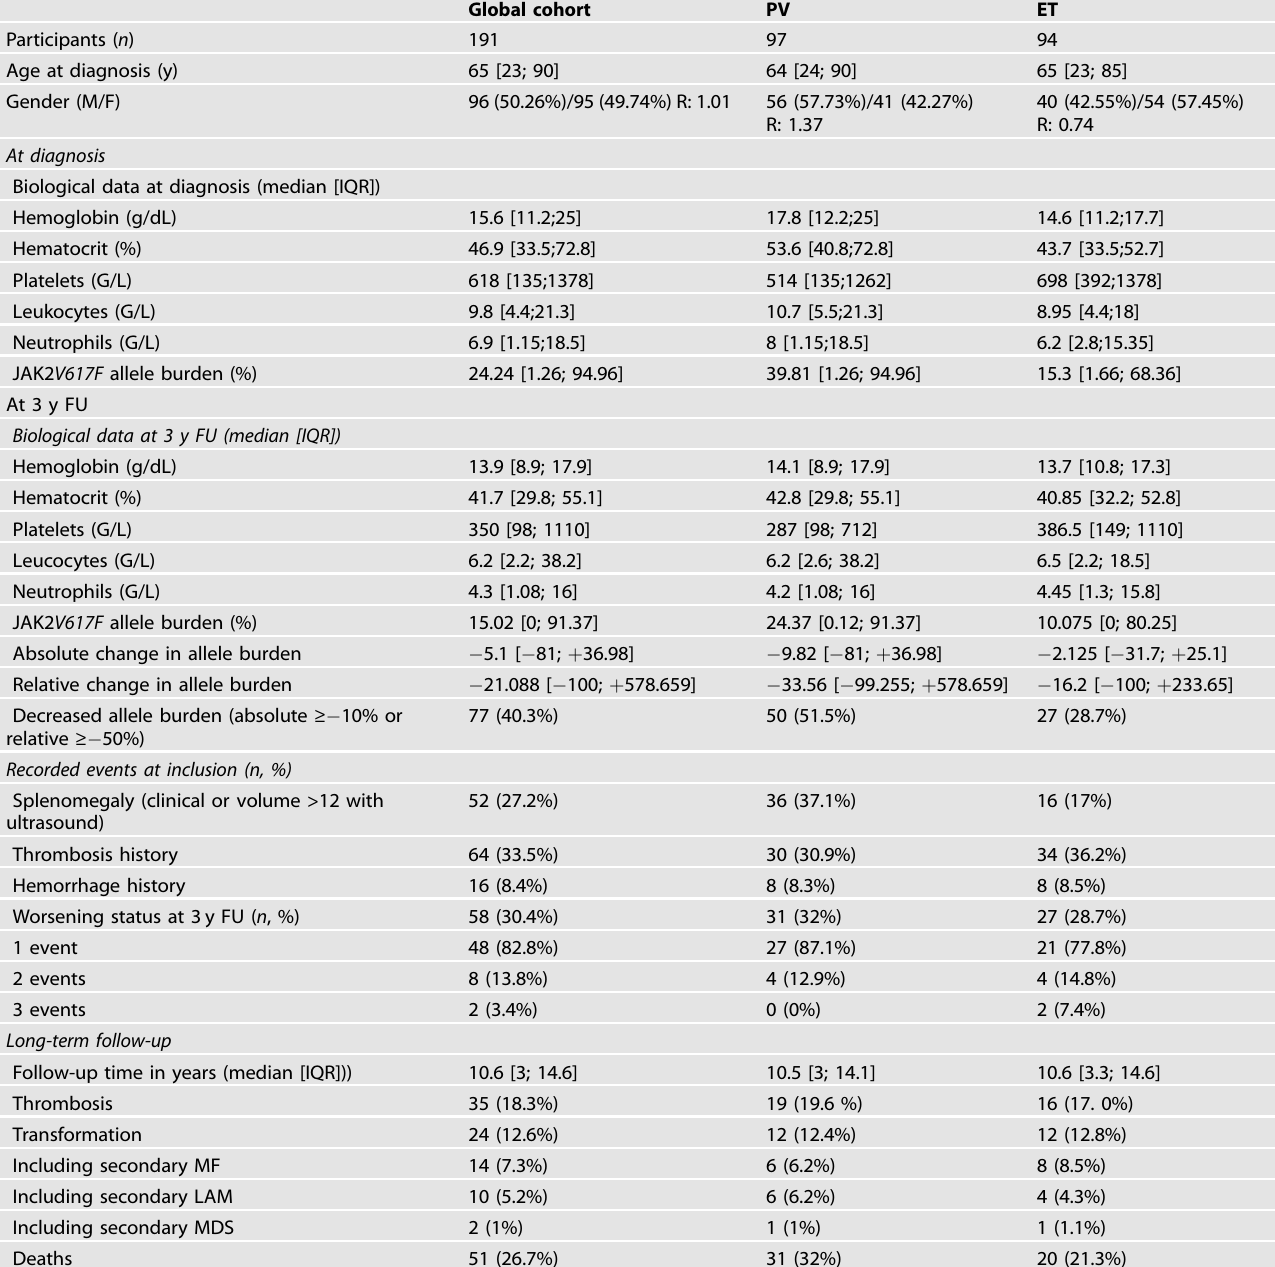
Table 1. Characteristics of the whole